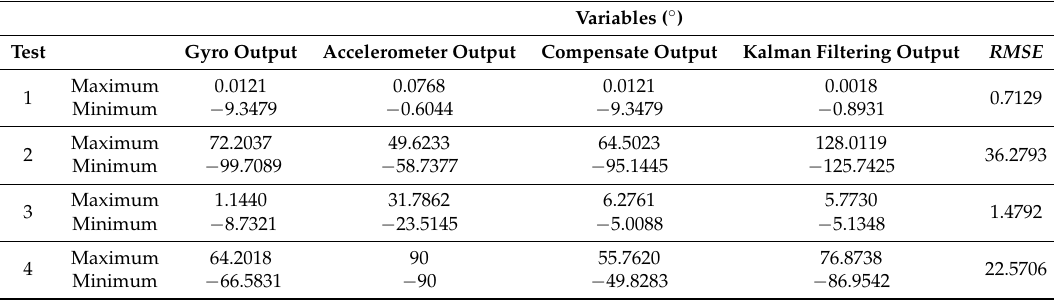
Table 1. Comparison values of different model